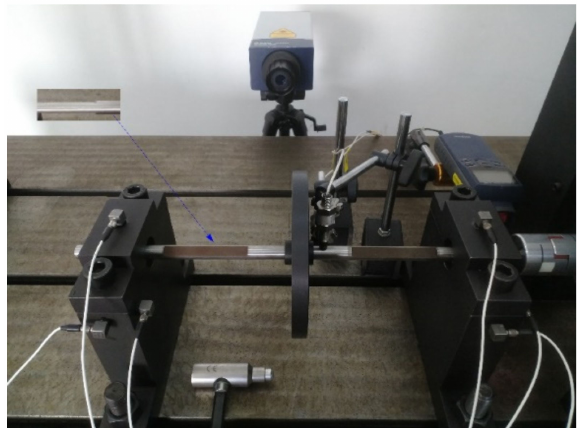
Figure 14. Experimental system of the asymmetric